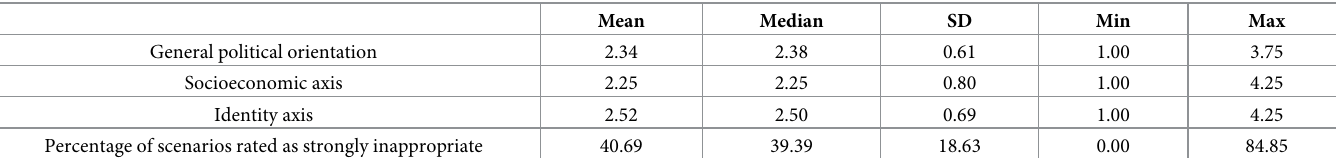
Table 3. Descriptive statistics.